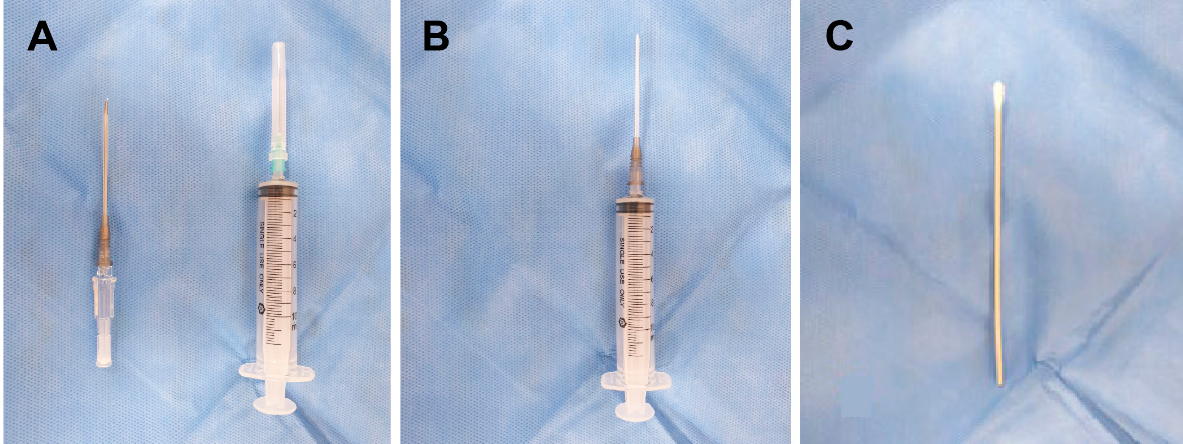
Figure 2. The tools for transnasal sphenopalatine ganglion block. ( A ) Angiocath, 10 mL syringe. ( B ) Syringe connected with Angiocath. ( C ) Cotton tip applicator. ( B ) Syringe connected with Angiocath. ( C ) Cotton tip